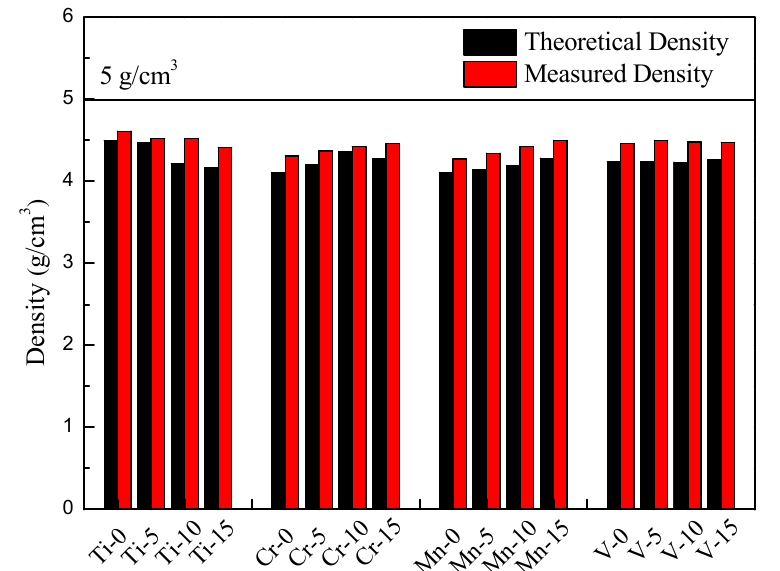
BCC phase is harder and more brittle than the FCC phase. With the fraction of BCC phase increase, the strength will be enhanced. This phenomenon can also explain why Al 50 (CrMnV) 50 and Al 50 (CrMnV) 45 Ti 5 alloys are too brittle to be cast successfully. Despite the theoretical Young’s modulus decrease as the V content increases, the hardness of the MEAs will increase with the V adding due to the fraction of BCC phase increase. There- fore, it is proved that the increase of the ratio of the BCC phase is more dominant than Figure 1. Density of the Al 50 –Ti–Cr–Mn–V alloys. Figure 1. Density of the Al 50 –Ti–Cr–Mn–V alloys. Young’s modulus in improving the mechanical properties of the MEAs.